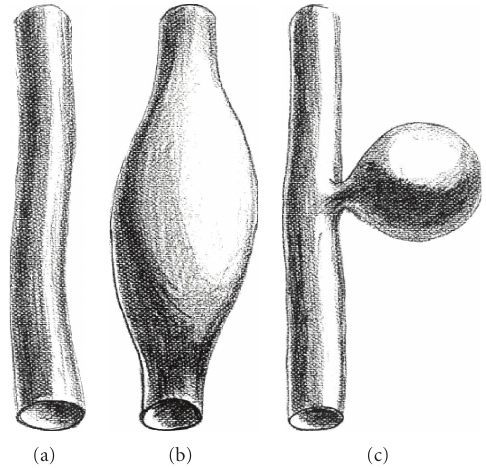
Figure 1: Schematic drawing of (a) a normal vein, (b) a phlebecta- sia, and (c) an aneurysm (courtesy of Seppo Piirainen, Peijas-Rekola Hospital, Vantaa).